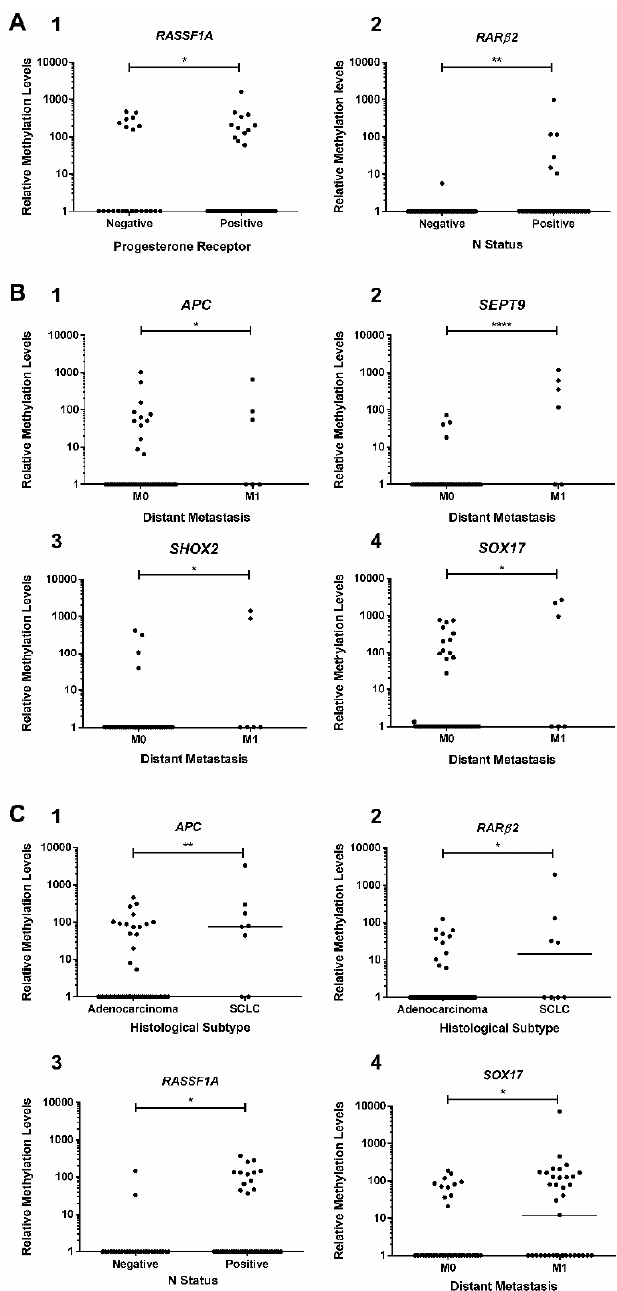
Figure 2. Scatter plot of ( A ) (1) RASSF1A promoter’s methylation levels in PR-positive or negative breast cancer (BrC) patients (Negative n = 24, Positive n = 94); (2) RAR β 2 promoter’s methylation levels between regional node (N) status in BrC patients (Negative n = 65, Positive n = 43), ( B ) (1) APC ; (2) SEPT9 ; (3) SHOX2 and (4) SOX17 promoter’s methylation levels between metastatic (M1) and non-metastatic colorectal cancer (CRC) patients (M0) (M0 n = 66, M1 n = 6), and ( C ) (1) APC and (2) RAR β 2 promoters methylation levels for histological subtype [Adenocarcinoma n = 56, Small-cell Lung Cancer (SCLC) n = 8], (3) RASSF1A promoter’s methylation levels for regional node (N) status in lung cancer (LC) patients (Negative = 27, Positive = 45) and (4) SOX17 promoter’s methylation levels between metastatic (M1) and non-metastatic LC patients (M0) (M0 n = 36, M1 n = 37). Mann Whitney U, n.s. p > 0.05, * p < 0.05, ** p < 0.01, **** p < 0.0001. Black horizontal line represents the methylation levels’ median.